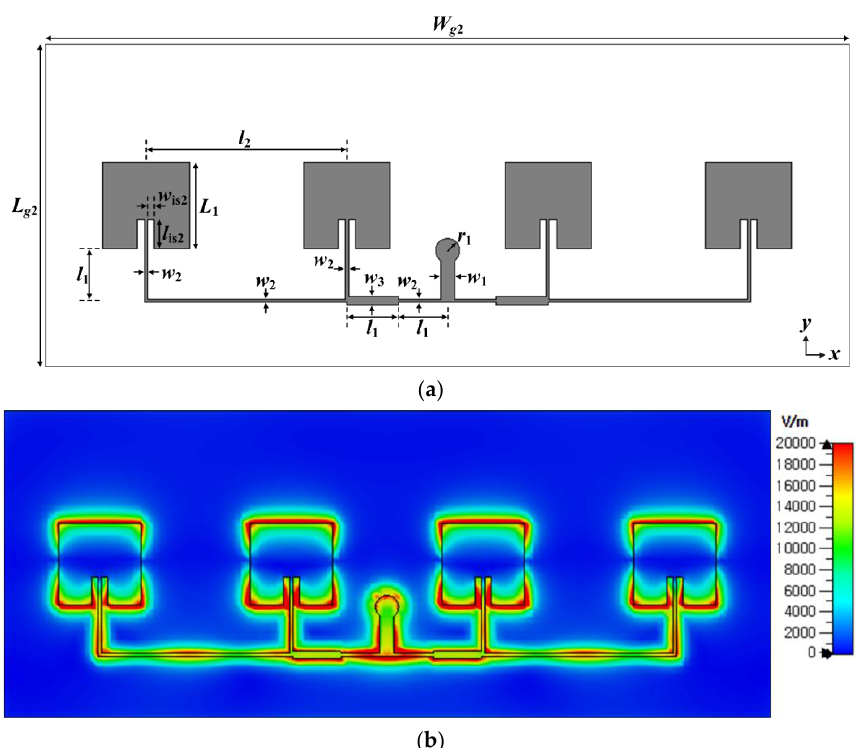
Figure 4. Design and electric field distribution of the 4 × 1 microstrip square patch array antenna combined with a shunt-connected series feed network using a uniform power distribution: ( a ) the geometry and ( b ) the electric field distribution at 24.125 GHz.